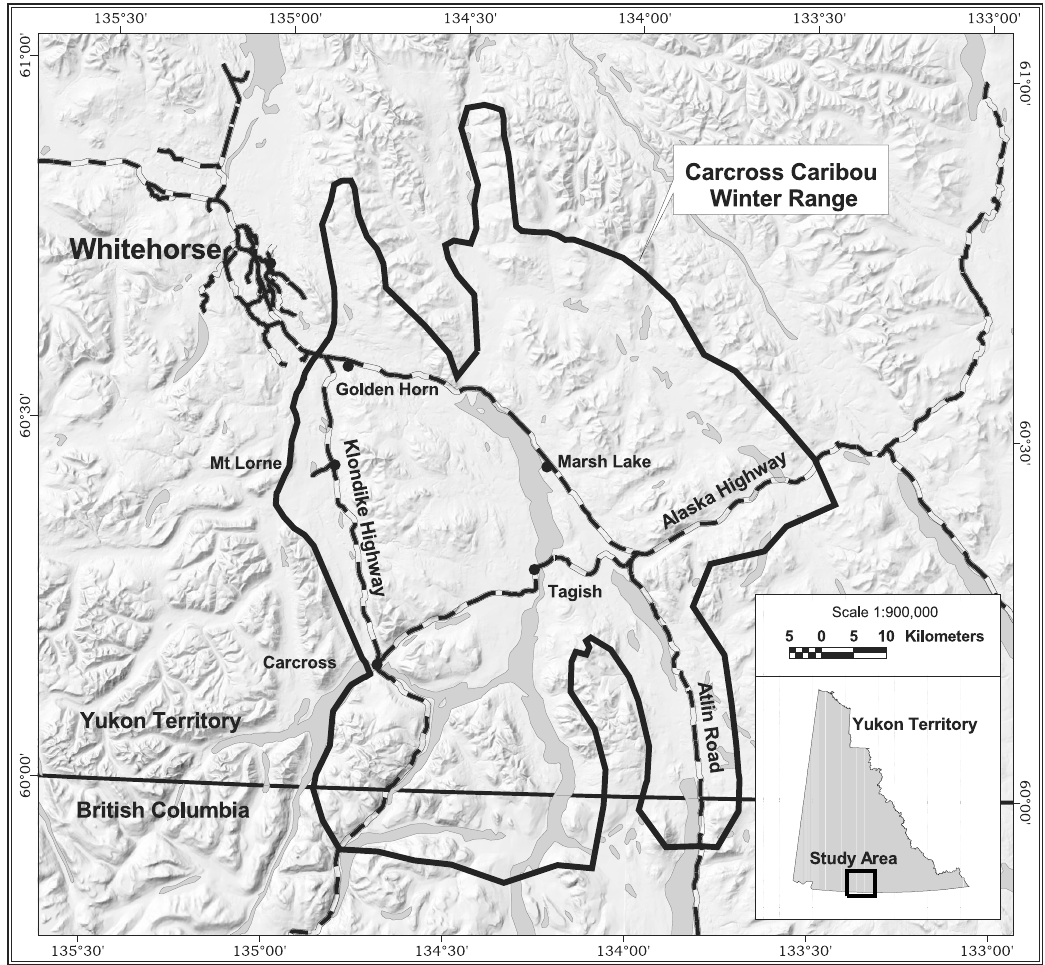
Fig. 1. Location of Whitehorse, outlying communities and major highway corridors relative to the Carcross caribou winter